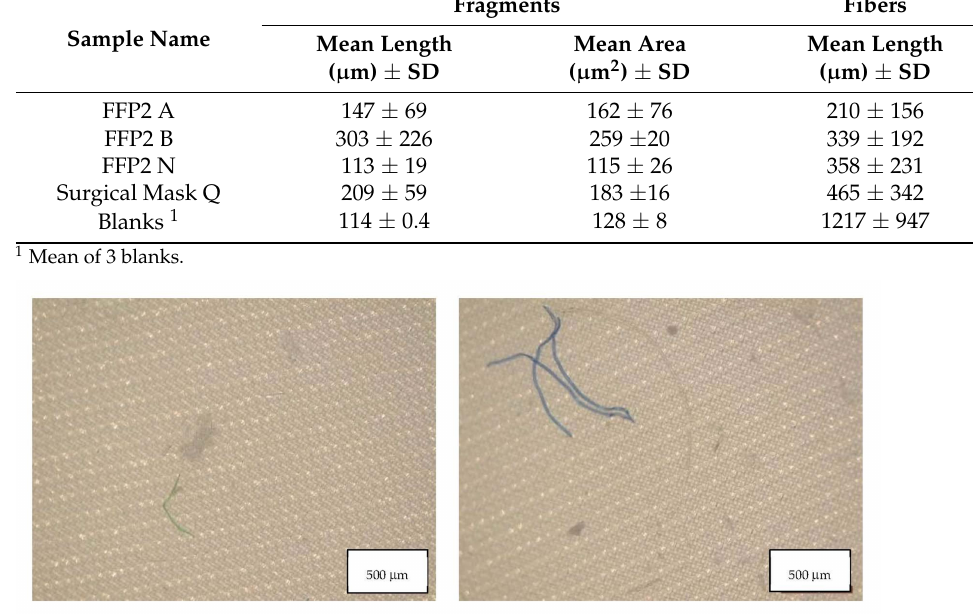
Figure 8. Microplastics detected in the filter of FFP2 A seen at the stereomicroscope with scale bar of 500 µ m.